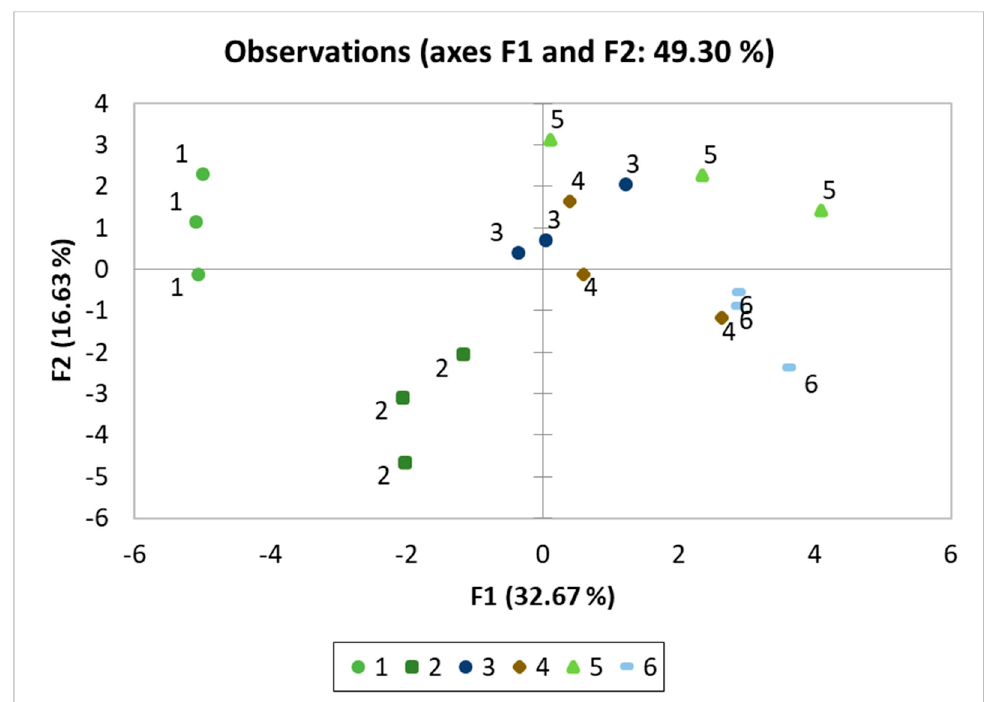
Figure 5. The principal component analysis (PCA) scatterplot, indicating distinct differences in carbohydrates, phenols DPPH and ABTS radical scavenging activity, organic acids and elements in cv. Rubin apples on harvest time (commercial ripening) in average of three years. 1. Each year hand pruning forming slender spindle (control); 2. Mechanical pruning (each year); 3. Trunk incision using chain saw + mechanical pruning (each year); 4. Mechanical pruning (each year) + spraying with calcium-prohexadione; 5. Mechanical pruning + hand pruning + summer pruning; 6. Mechanical pruning one side, changing sides annually.